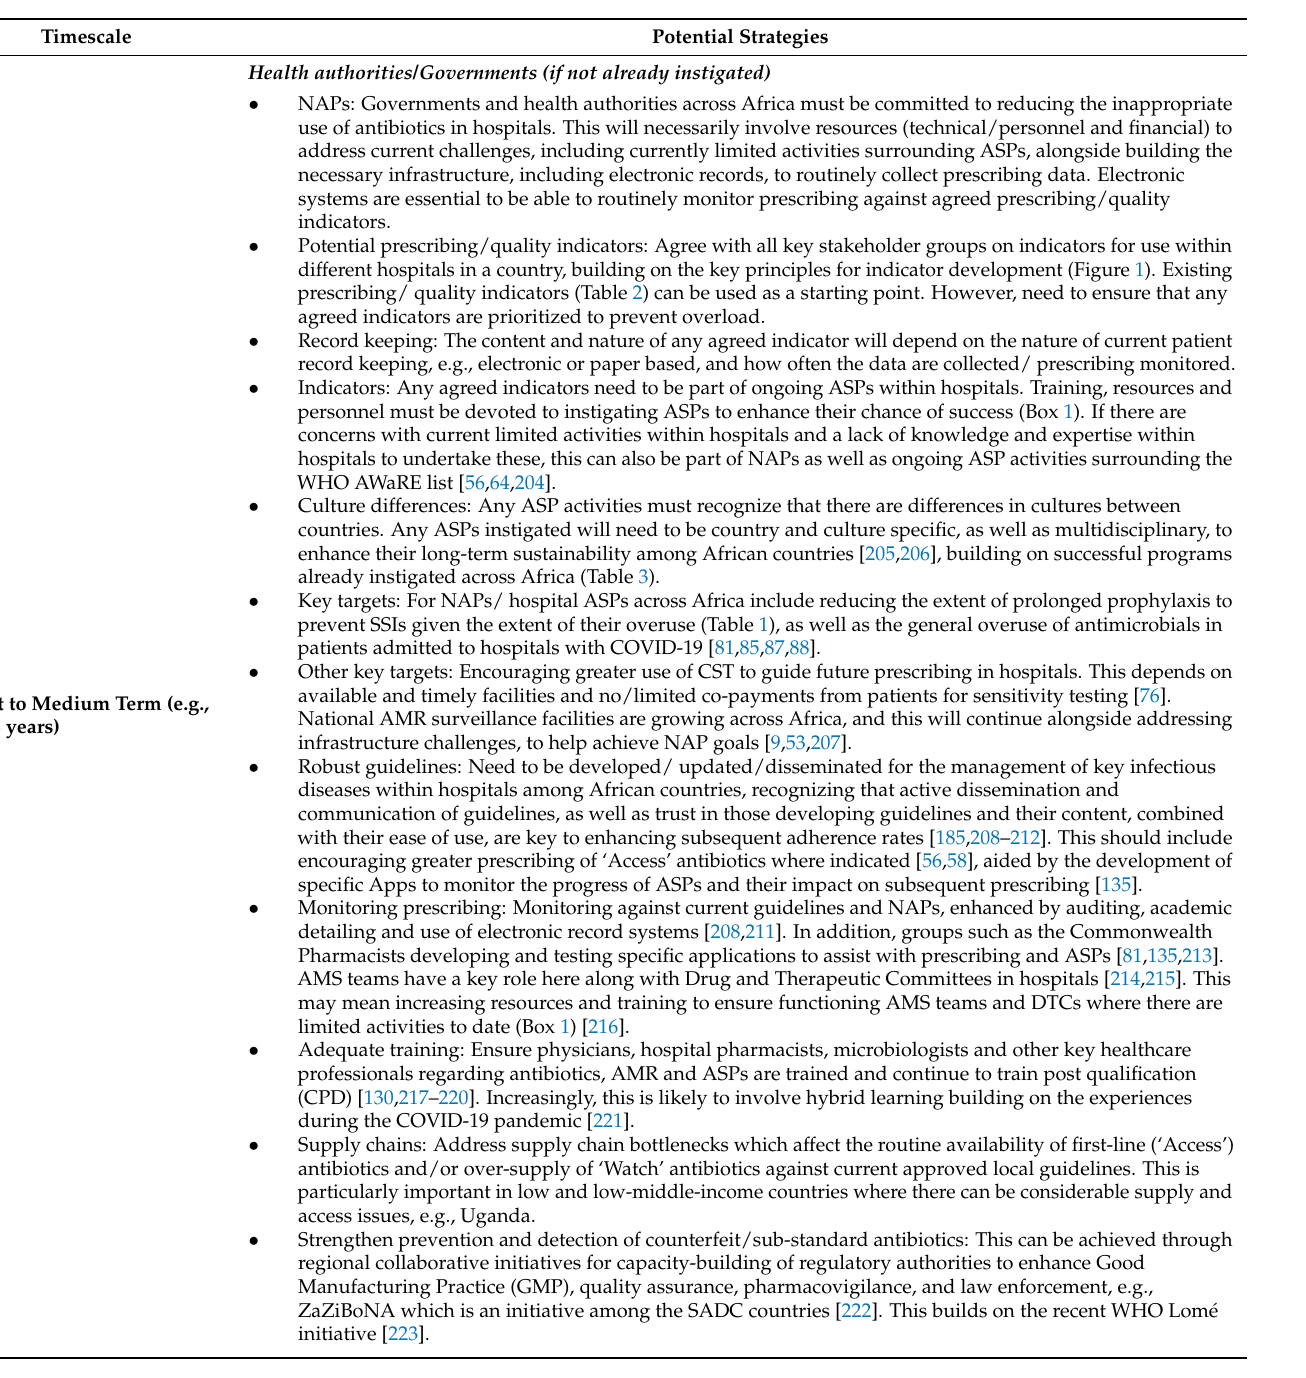
Table 4. Suggested strategies to improve future antimicrobial utilization among hospitals across